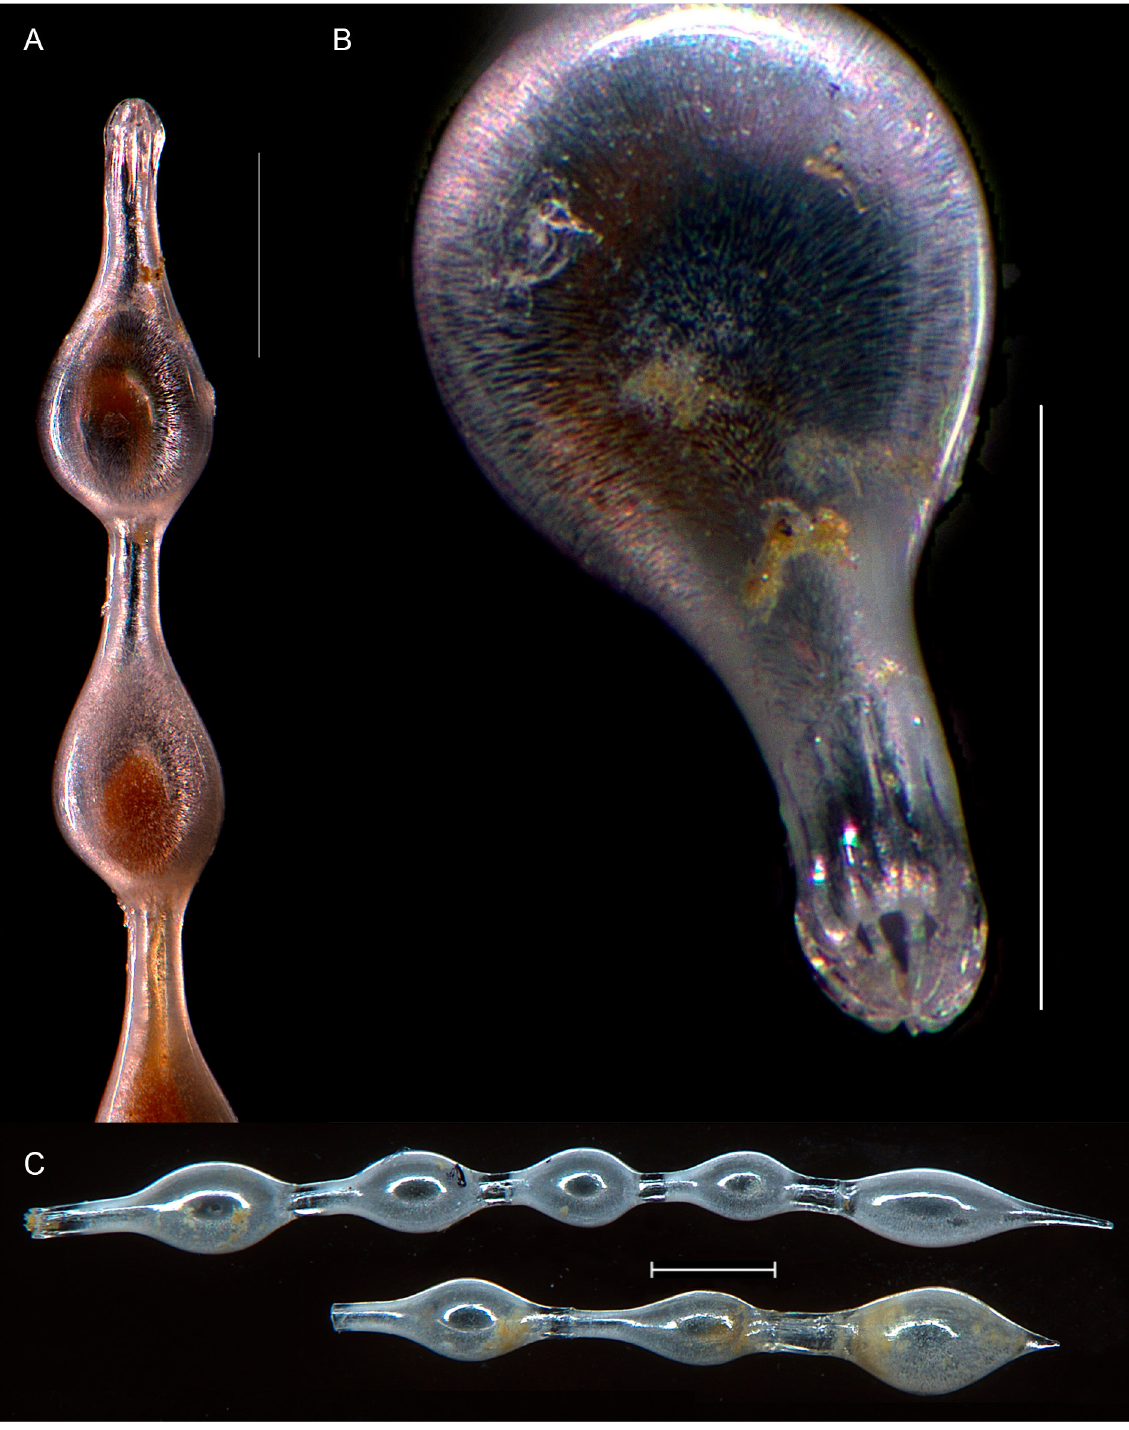
Fig. 8. Grigelis pyrula (d’Orbigny, 1826). A–B . Specimen with missing initial end (BIOICE 2424, IINH 40388), side view (A) and detail of aperture (B), stained with indigo blue. C . Megalospheres (BIOICE 2966, IINH 40390), initial ends of specimens with damaged apertures. Light source combination of incident light and dark field. Scale bars = 0.25